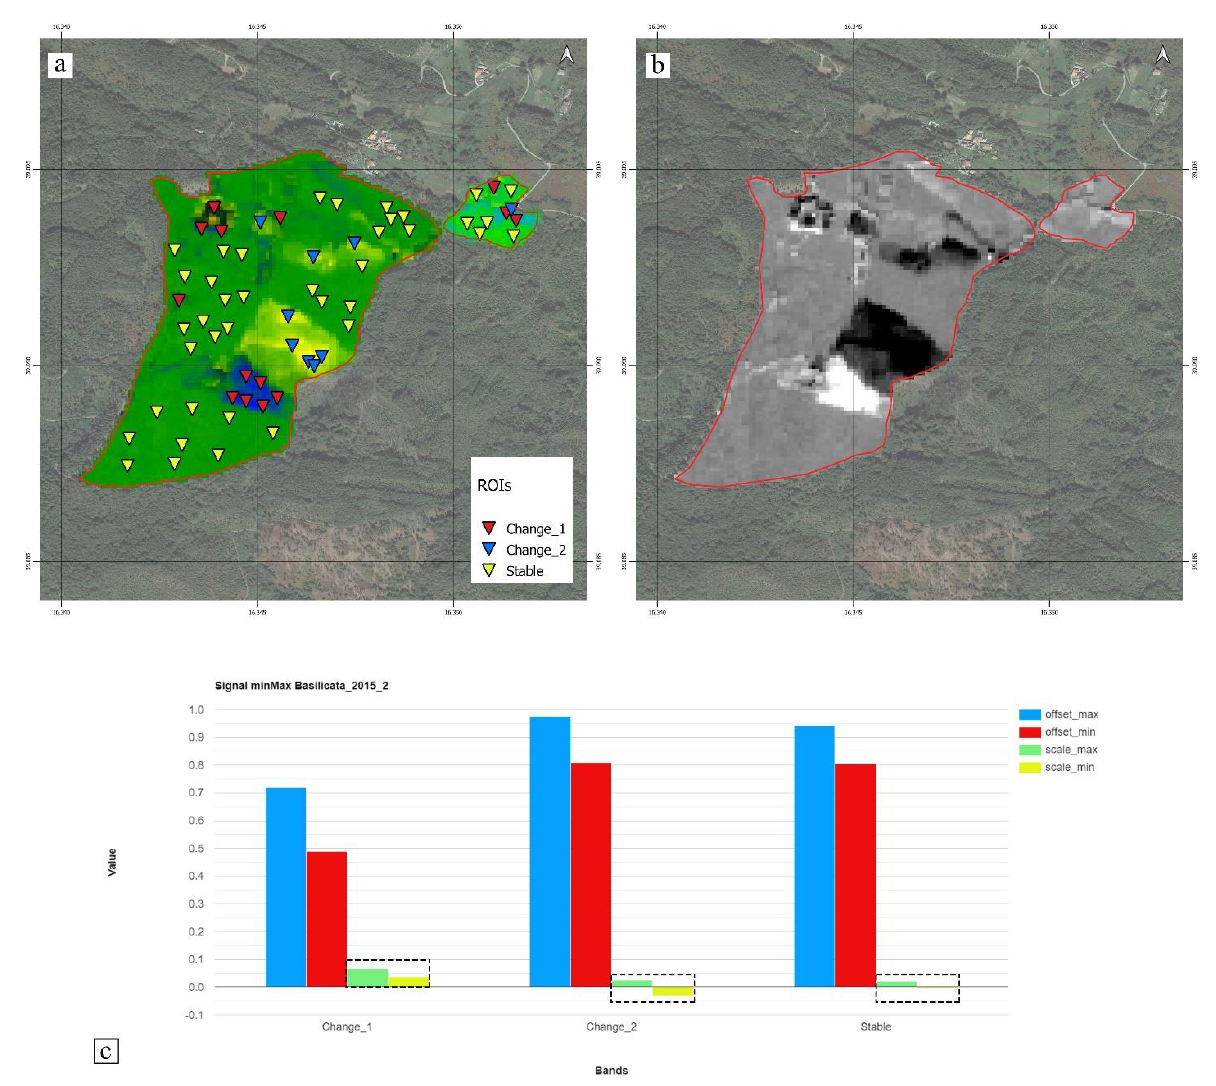
Figure 5. ( a ) RGB obtained using R: slope, G: Offset, B: slope; ( b ) single-band image of slope (scales): positive values are light, negative values are dark, grey areas represent values very close to 0; ( c ) pixel value graph obtained from ROIs in ( a ).